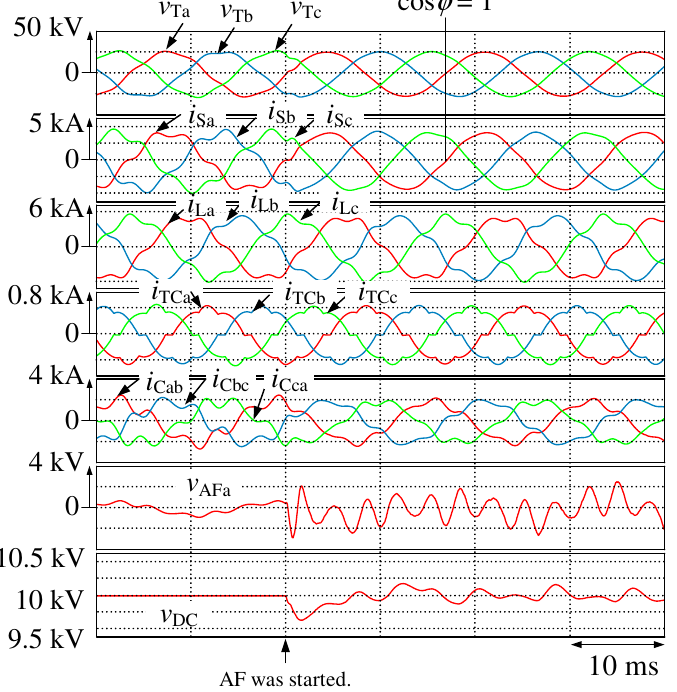
Figure 9. Simulation waveforms for Figure 4 before/after the series active filter (AF) with K C of 30 Ω was